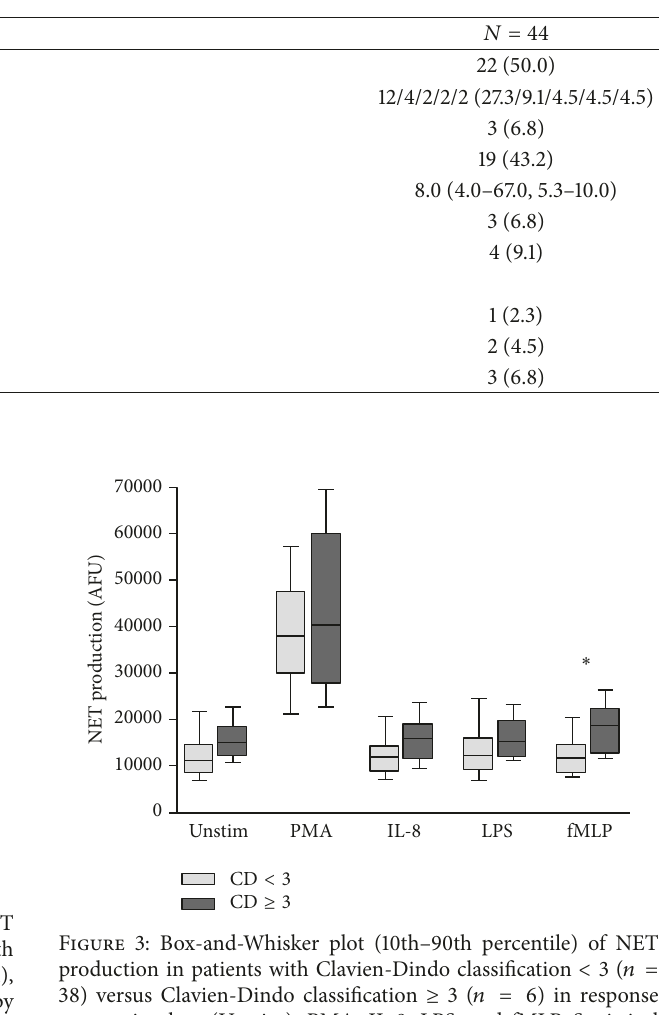
Table 3: Patient outcomes.